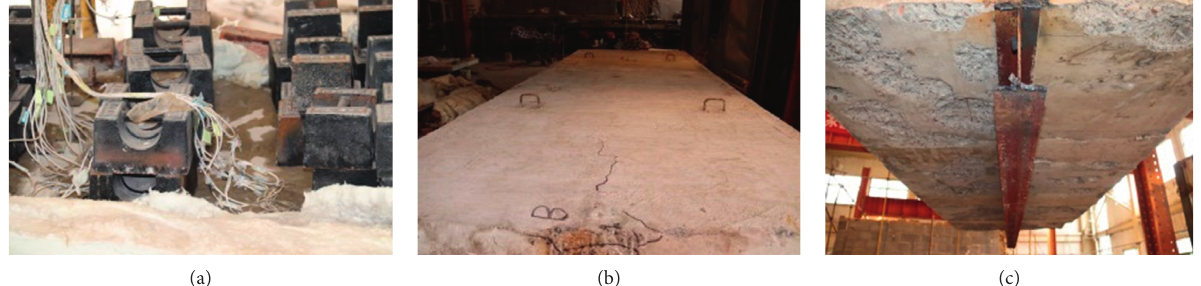
Figure 6: Failure modes of SCB-1: (a) water bay, (b) cracks on the top surface of the slab, and (c) local bursts on the bottom surface of the slab.